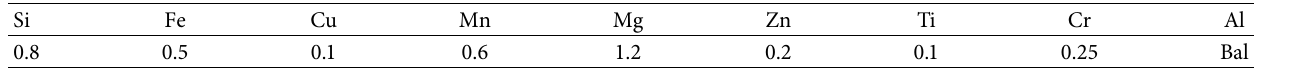
Table 1: AA 6082 chemical elements.